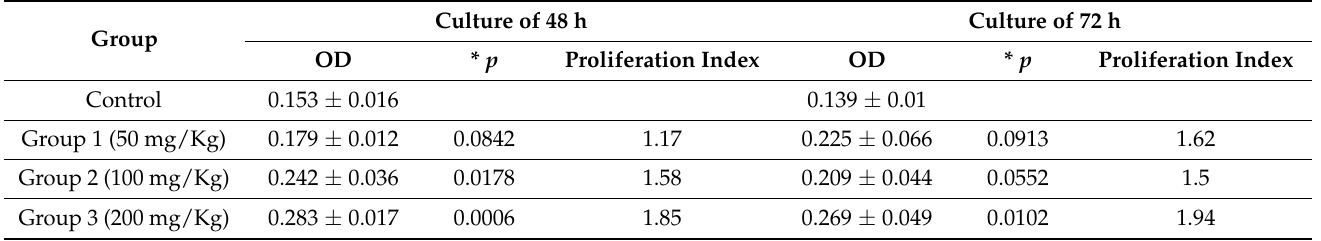
Table 15. Effect of the administration of the novel nutraceutical in three different concentrations on mice lymphocyte proliferation—conA